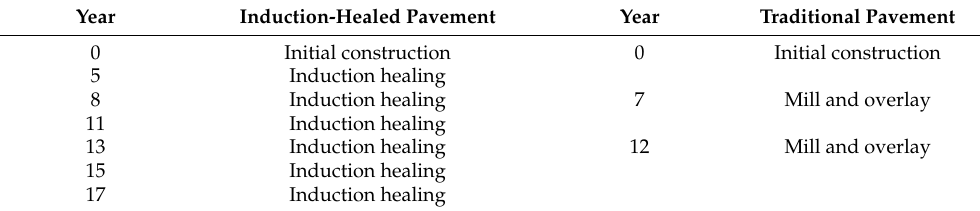
Table 7. Maintenance schedule.